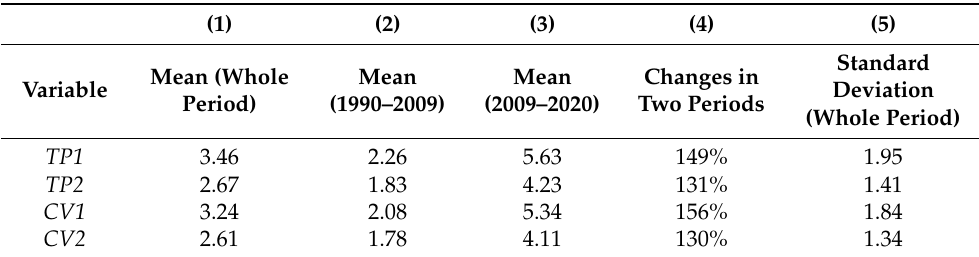
Table 1. Descriptive statistics of the four house submarkets price